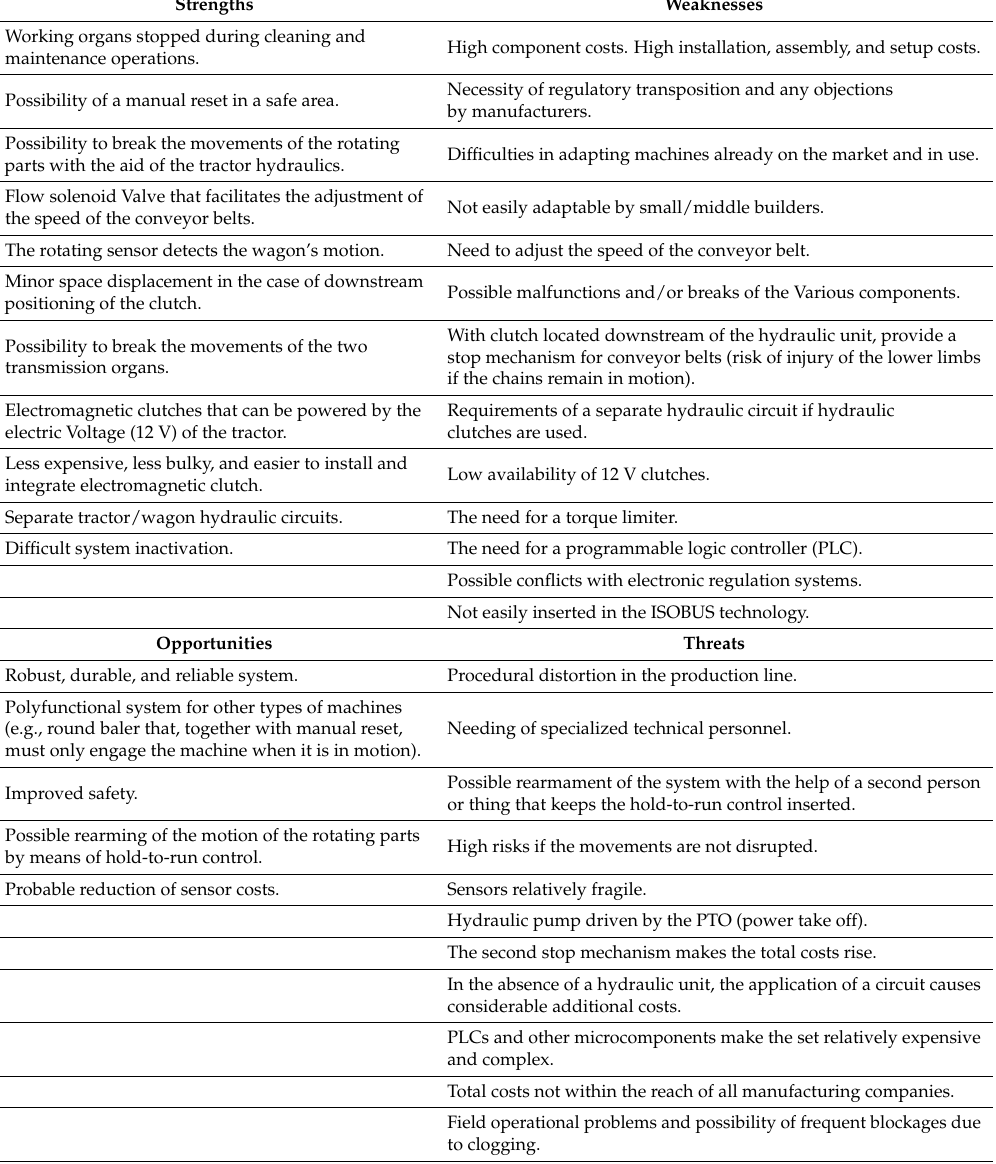
decoupling device. Strengths